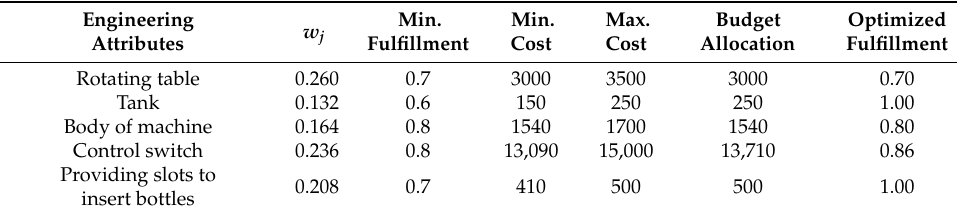
Table 7. Cost information and optimal results for engineering attributes.